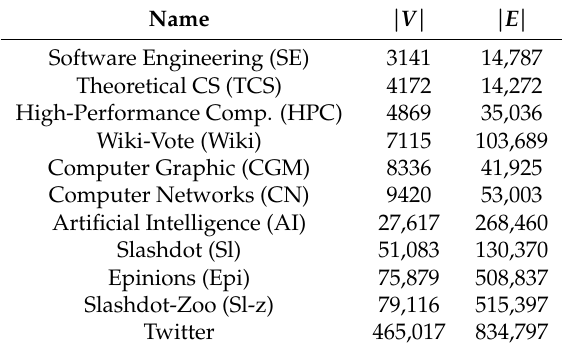
( c (cid:63) , ∅ ) − F ( c , ∅ ) and ∆ ( S ) = F A 0 0